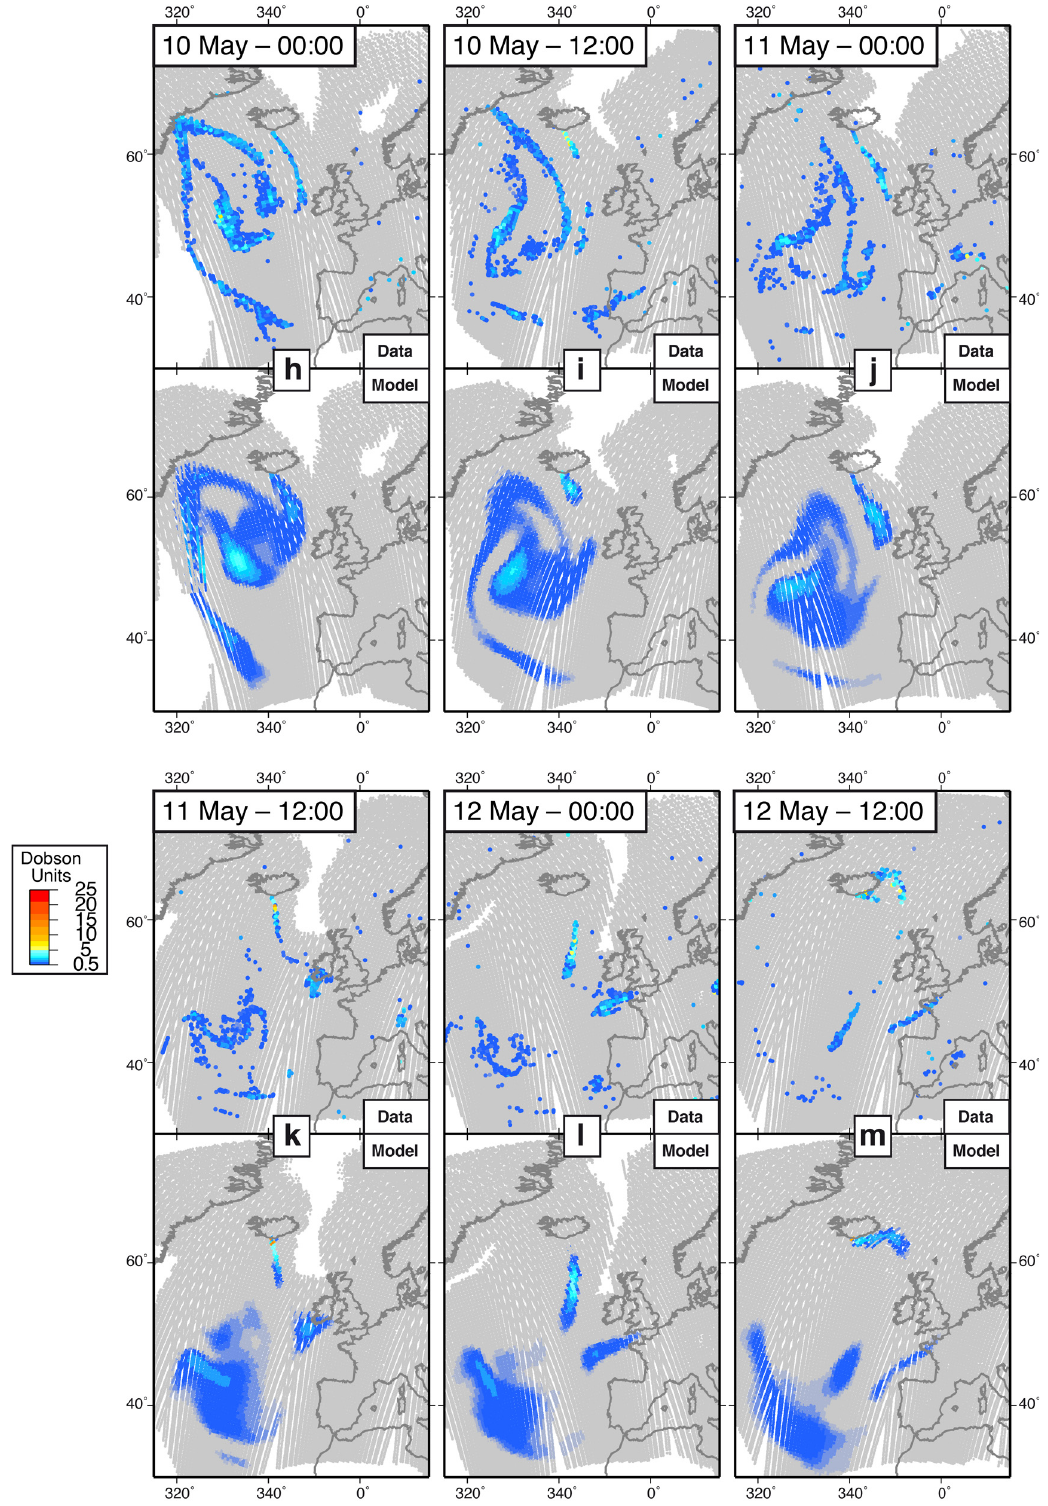
Fig. A2. Continuation of Fig. A1 including maps numbered h to m